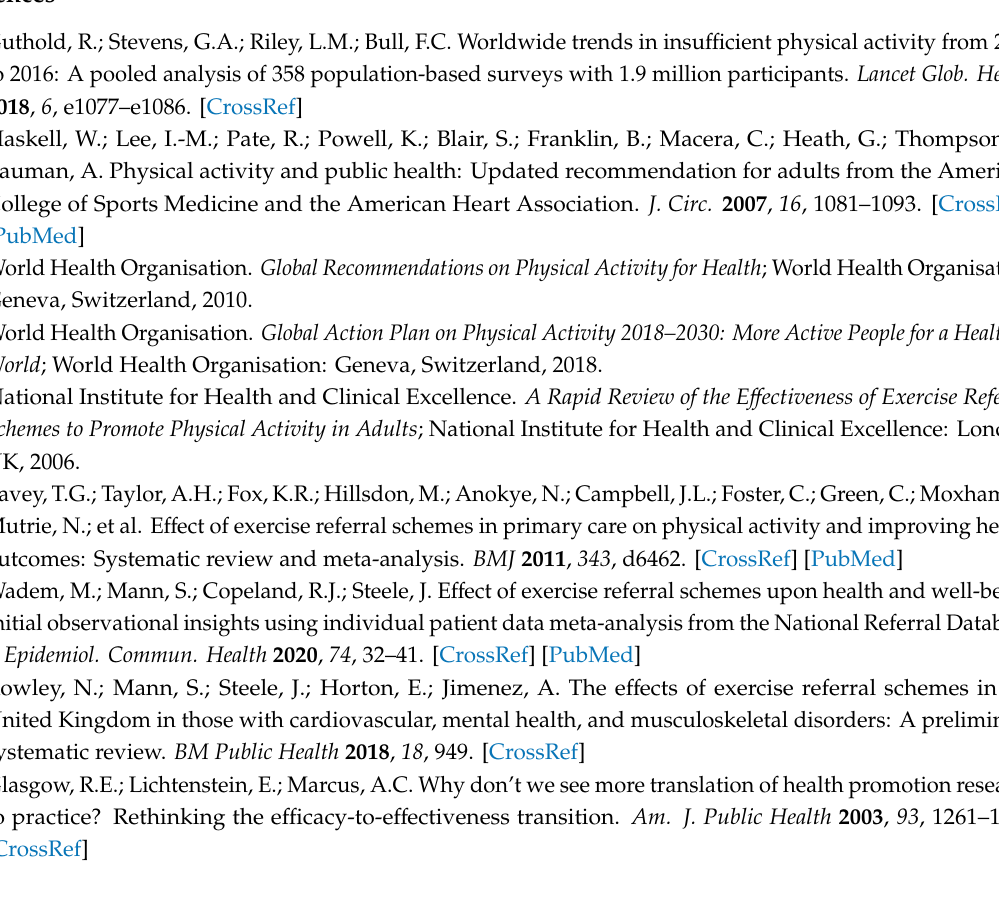
Table S1: Records of NERS referrals with no data linkage ( N =